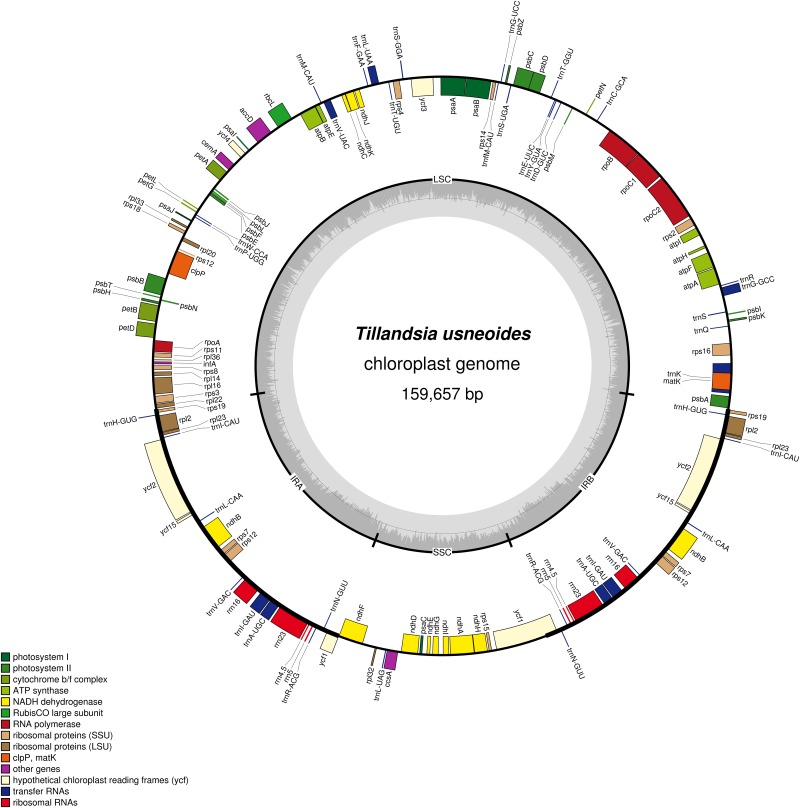
The circular representation of the plastid genome of Spanish moss (Tillandisa usneoides).Structural organization of the gene content ring was color coded based on its functional category. The innermost circle denotes the GC content across the genome. The genes that were transcribed counter-clockwise and clockwise were at the outer and inner ring, respectively. The illustration was drawn using OGDRAW.